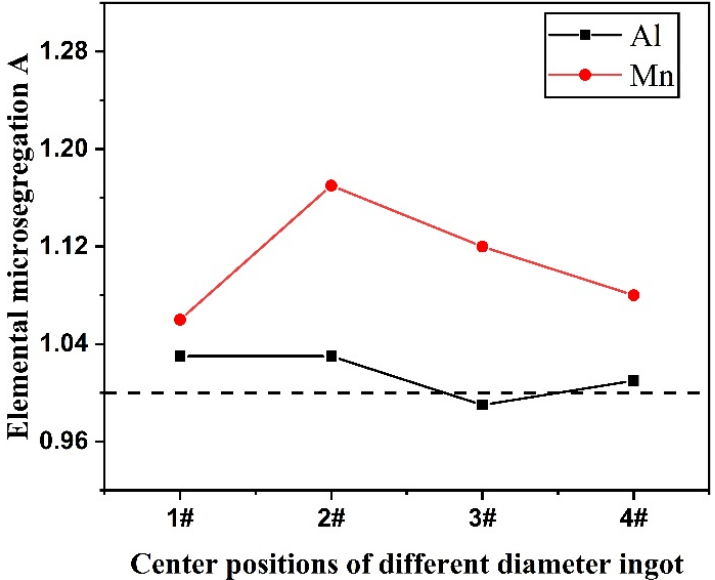
Figure 12. Microscopic segregation of elements at the center of the ingot with different diameters.